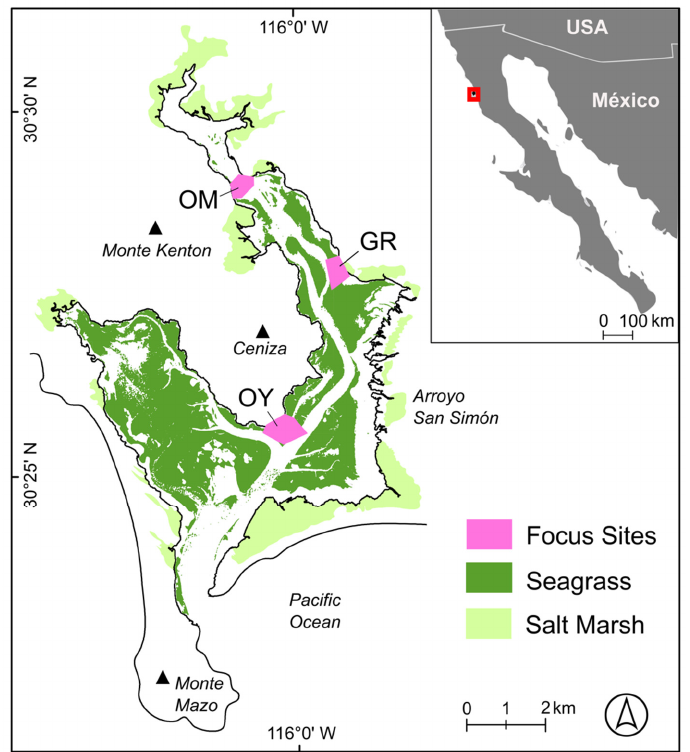
Figure 1. Study site Bahía San Quintín is located at the Pacific coast of Baja California, México. The focus sites Old Mill (OM), Graveyard (GR), and Oyster (OY) were surveyed seasonally. Approxi- mate extent of seagrass meadows (dark green) and salt marshes (light green) are shown.